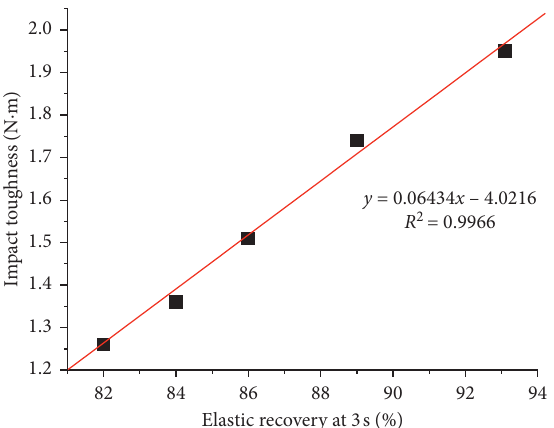
Figure 8: Correlation of impact toughness and elastic recovery at